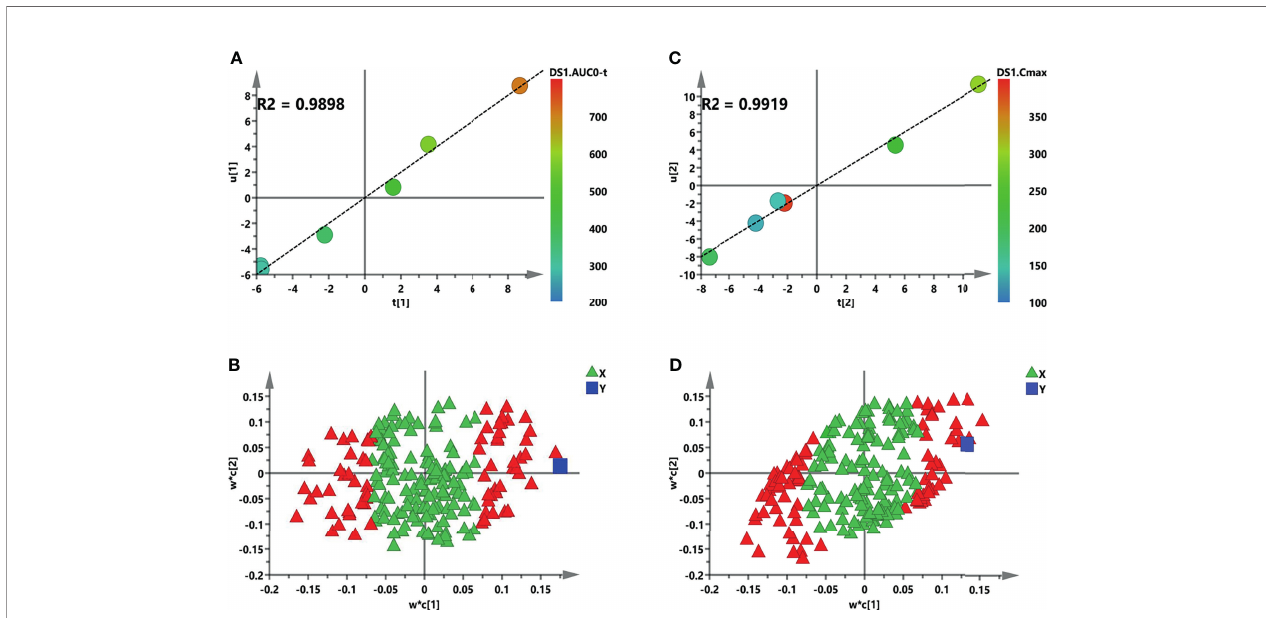
FIGURE 7 | Initial partial least squares (PLS) models of the pre-dose metabolic pro fi les for predicting the pharmacokinetic (PK) parameters of sotorasib. (A, B) Score plots for the fi rst latent variable of the AUC 0 – t and C max prediction models, respectively. Each dot represents a rat, plotted as the fi rst latent variable ( X block) vs. the AUC or C max ( Y block). Color from blue to red represents the response variable from low to high. (C, D) Loading plots for the AUC and C max prediction models, respectively. The blue box represents the response variable. Each triangle represents a metabolite, and the triangles in red represent the metabolites with variable importance in the projections (VIP)